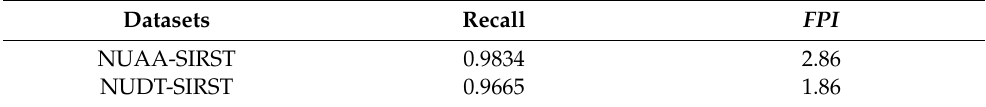
Table 3. Candidate extraction results.